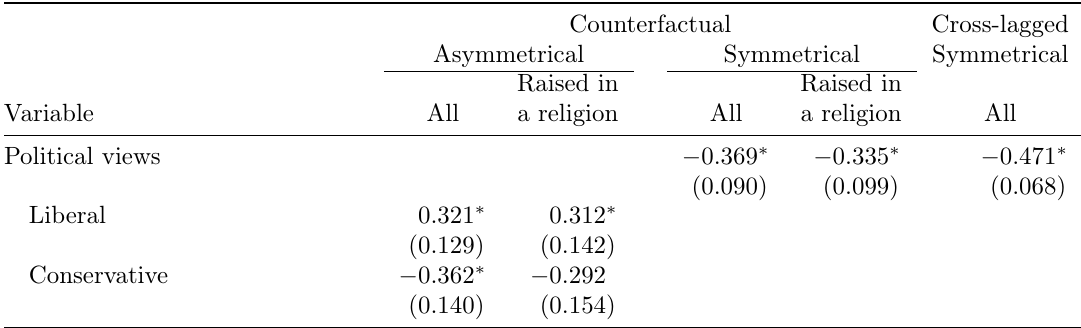
Table 3: Estimates of the Effect of Political Views on Preferring No Religion by Model and Subsample: Adults, United States, 2006–2012.